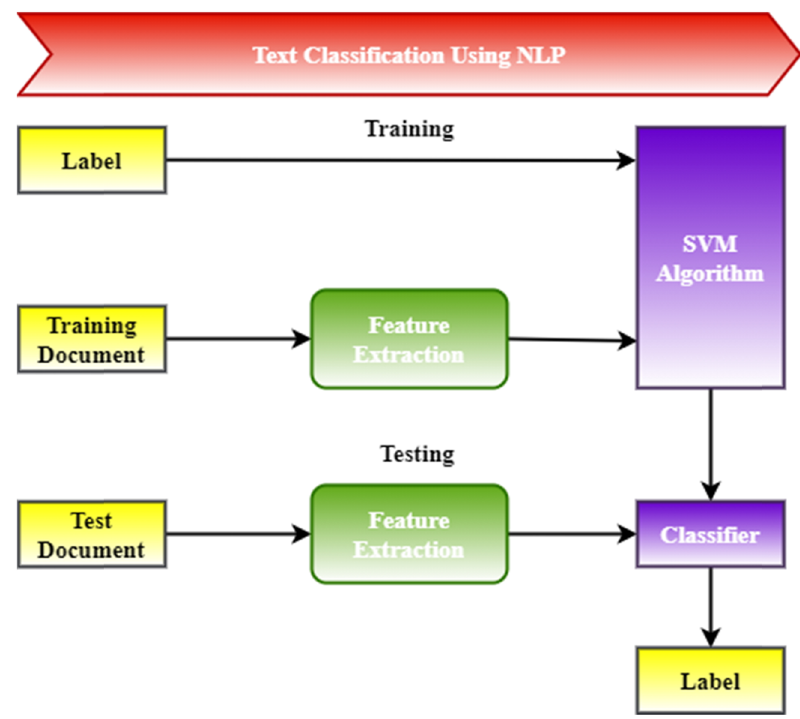
Figure 2: Text classi fi cation using